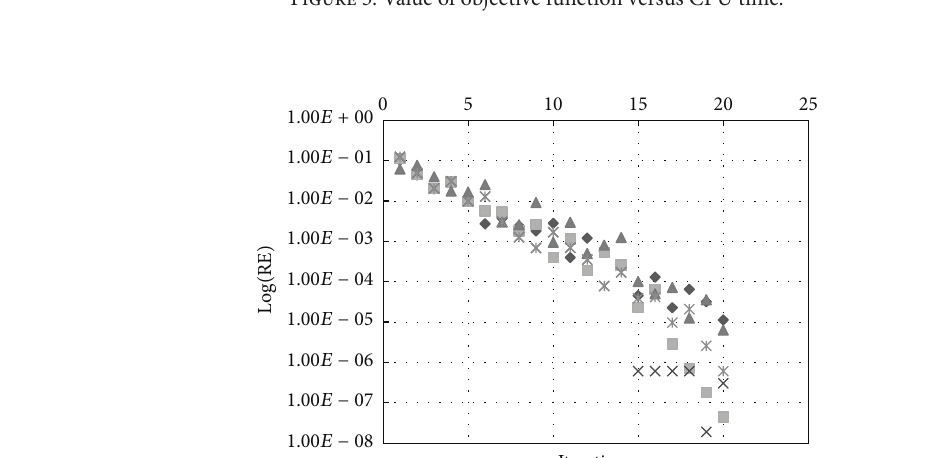
Figure 3: Value of objective function versus CPU time.